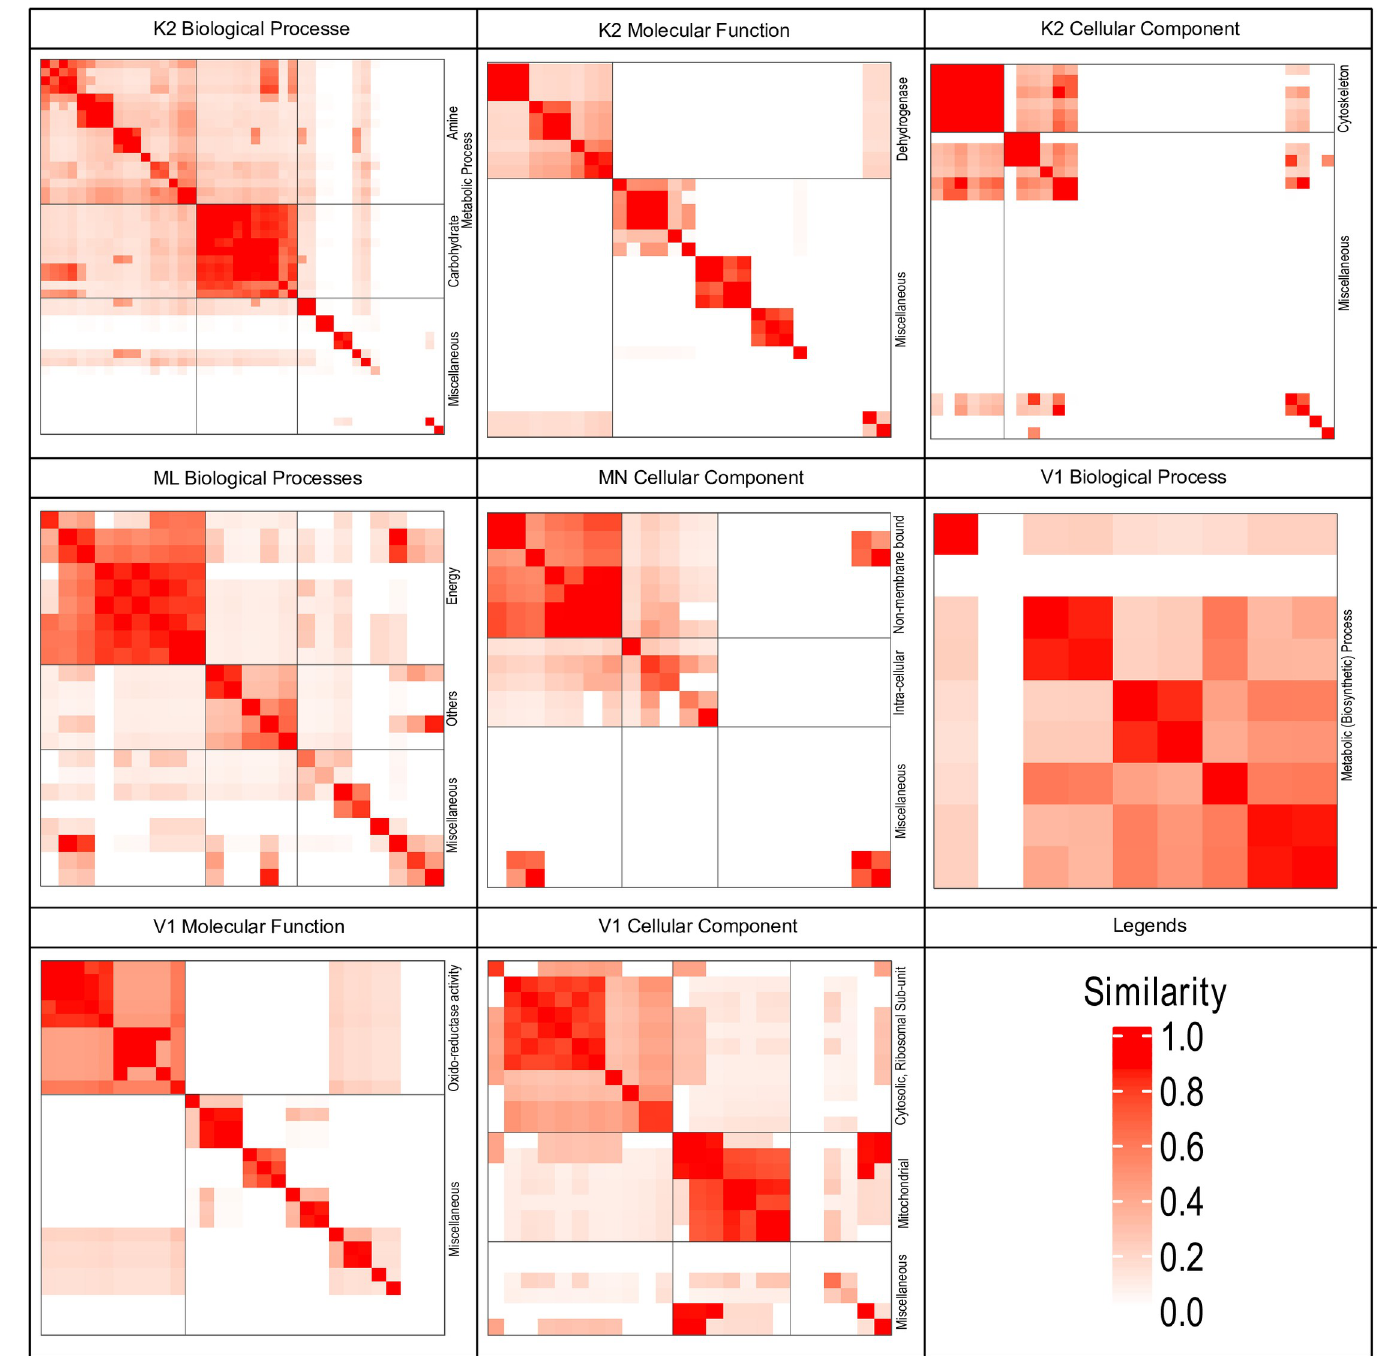
Fig 6. Similarity matrices of unique GO terms obtained for K2, V1 ( Morus indica cultivars) and ML, MN and MS leaf transcripts. Similarity matrices are represented using heat maps that represent the similarity among GO terms and cluster them using binary cluster method. (See legend for similarity levels).